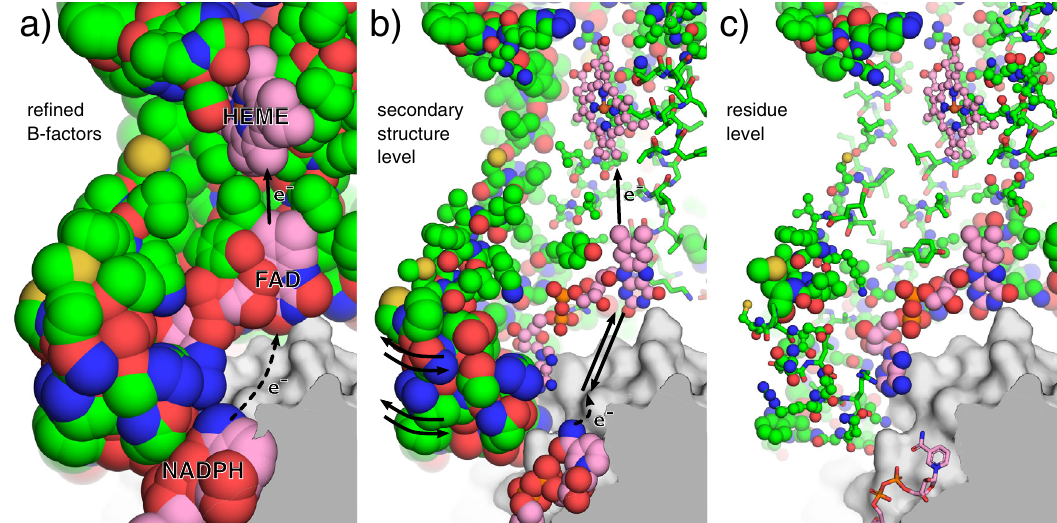
Fig. 7 Putative fl exibility-based mechanism of electron transport in STEAP4. Cutaway view of a wing of the STEAP4 molecule (6hcy). Representation as in Fig. 6 except for colour: for chain A, protein carbon atoms are shown in green, and non-protein carbon atoms are pink; atoms are otherwise coloured by element. a Deposited B-factors. The electron transport pathway in STEAP4 requires the transfer of a hydride ion from the bound NADPH molecule to the FAD molecule, which subsequently transfers two electrons to the heme molecule, which subsequently reduces bound substrate molecules, Fe 3 + /Cu 2 + ions. The pathway for transfer of the hydride from the NADPH molecule to the FAD molecule is unknown 19 . b ECHT secondary-structure level. The observed fl exibility suggests a mechanism whereby shuttling of the FAD molecule, caused by breathing of the fl exible wing, brings the FAD fl avin moiety in close proximity to the NADPH, where it can gain the hydride, and then subsequently transfer electrons to the heme molecule upon returning to the solved state. c The residue level reveals that the FAD molecule has increased disorder relative to its surroundings, further suggesting that structural transitions could be possible. Images rendered in pymol 29 For TLS-re fi ned structures, the TLS contribution can either be included in the atomic ADPs (resulting in a-ADPs), or excluded (resulting in i-ADPs). Hierarchical model partitioning . Default TLS group partitions are created for each: protein chain; local secondary-structure element; residue; and residue back- bones/side chains. Secondary structure is automatically identi fi ed with the DSSP algorithm 24 as implemented within the cctbx 25 ; C β atoms are included with backbone atoms. Glycine, Alanine and Proline residues are not considered in the backbone/sidechain levels. An atomic level is created with an a-ADP or i-ADP (depending on the input disorder model) for each atom. Part of an example composition is shown in Supplementary Fig. 24. All ECHT levels mentioned in this work use the above model composition unless stated otherwise. Custom levels can also be de fi ned, such as for individual domains within a chain, or across chains. To aid interpretability, levels should generally be ordered such that the largest groups appear at lower levels. ECHT model parameterisation . The overall schema of the parameterisation process is shown in Supplementary Fig. 23. In each macrocycle, the algorithm alternates between optimising the TLS parameters for each level using a simplex- based approach, and optimising the amplitudes of all model components (TLS groups for TLS levels, and ADP values for the atomic level), using a gradient-based method with elastic-net penalties. Between the macrocycles, elastic-net penalties are decayed by a chosen factor (between 0 and 1). Smaller values lead to a faster runtime but may miss model components (e.g., lead to a non-parsimonious model); large values lead to a longer runtime, but a much more detailed model. In this work, the decay factor is chosen to be 0.8, which was found to be a good balance between speed and model quality. Some minor differences may appear between symmetry-related monomers in a model; these can be a good indicator that the decay factor is too small. Within each macrocycle, each series of TLS and amplitude optimisations is repeated until the amplitudes of the components stop changing between each microcycle.